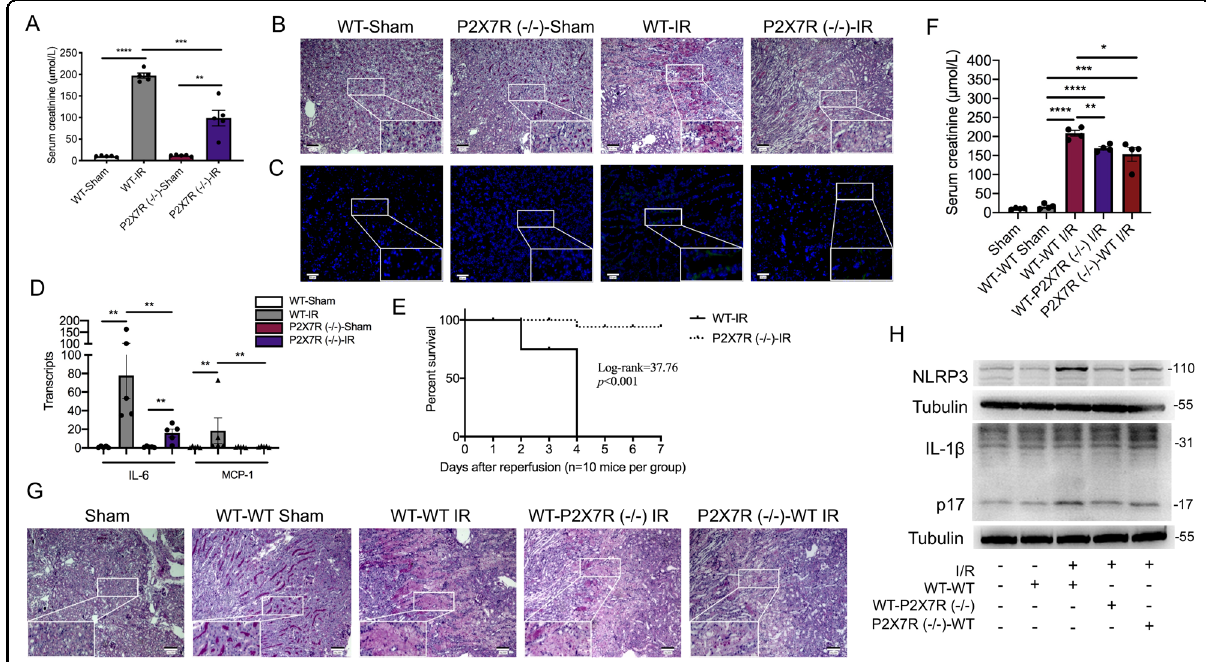
Fig. 3 P2X7 receptor gene knockout protected from renal ischemic-reperfusion injury. A – D Male C57BL/6 wild-type mice and P2X7 receptor ( − / − ) counterparts were subjected to renal ischemic-reperfusion or sham operation ( n = 5 per group). A The concentrations of serum creatinine. B Periodic acid Schiff staining of kidney sections. C Representative immuno fl uorescent staining for Ly6G (green) merged with DAPI. D The levels of IL- 6 and MCP-1 mRNA by real-time polymerase chain reaction. E The survival analysis for renal ischemic-reperfusion injury between wildtype and P2X7 receptor ( − / − ) mice ( n = 10 mice each group). F – H We constructed radiation-induced bone marrow chimeras between P2X7 receptor ( − / − ) and P2X7 receptor ( + / + ) mice. The mice were grouped into the wild-type bone marrow to wild-type recipient (WT – WT), the wild-type bone marrow to P2X7 receptor ( − / − ) recipient (WT – P2X7R ( − / − )), and the P2X7 receptor ( − / − ) bone marrow to wild-type recipient (P2X7R ( − / − )-WT) ( n = 4 per group), and then were subjected to renal ischemic-reperfusion injury or sham operation. F The concentrations of serum creatinine were measured. G Representative Periodic acid Schiff staining of kidney sections. H Representative immunoblots of whole-kidney lysate for the expression of IL-1 β p17 and NLRP3 proteins. * p < 0.05, ** p < 0.01, *** p < 0.001, **** p <